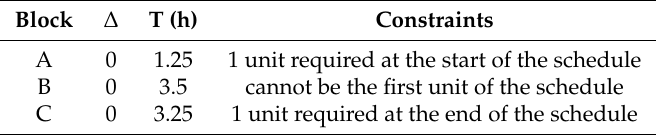
Table 1. Component details for Batch Reactor-Feed Effluent Heat Exchanger (BR-FEHE) system with direct integration.